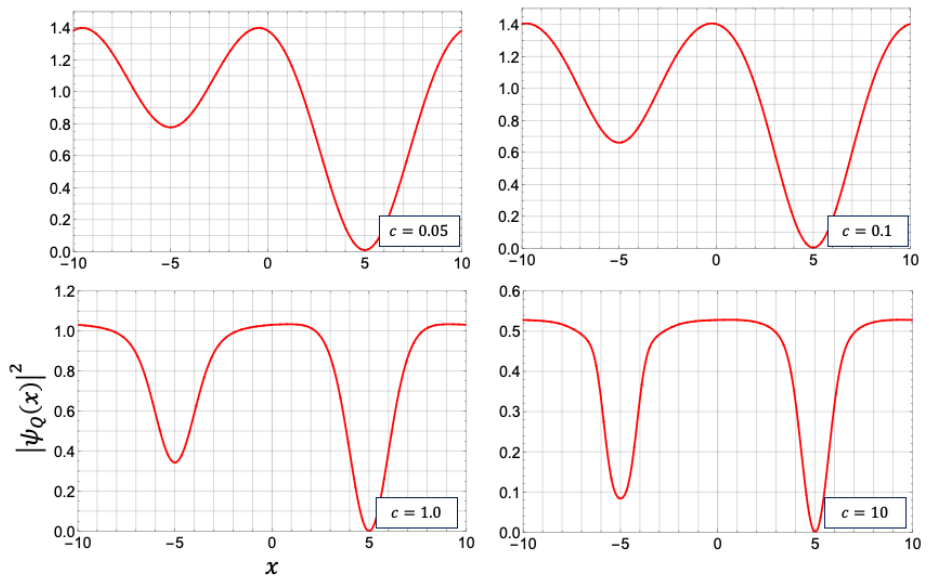
Figure 13. Square amplitudes of the matrix element, | ψ Q ( x ) | 2 , for N = L = 20, and c = 0.05, 0.1, 10, and 100. The pairs of the Gaussian parameters are given by the same sets of values as in Figure